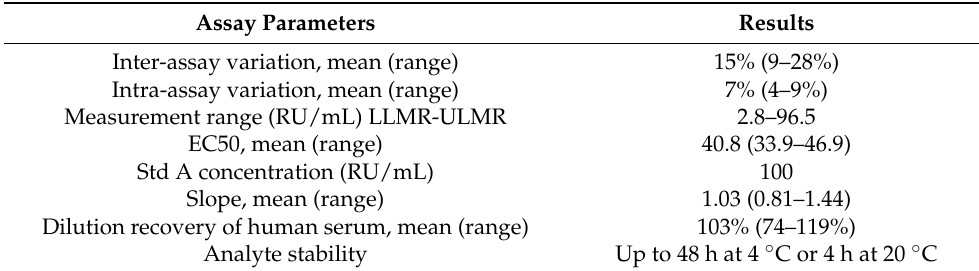
Table 1. Technical performance of the anti-dCol3 assay. Assay Parameters